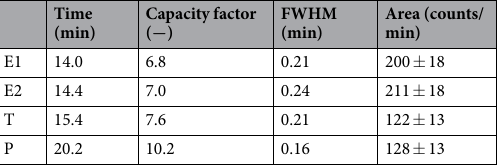
Table 1. The UHPLC-FSA separation results of hormone mixture (each 100